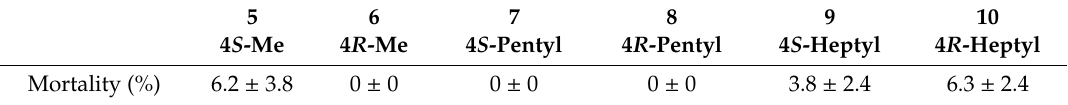
Table 1. Mortality of mosquito larvae after application of ficifolidione derivatives (mean ± SEM, n = 4).